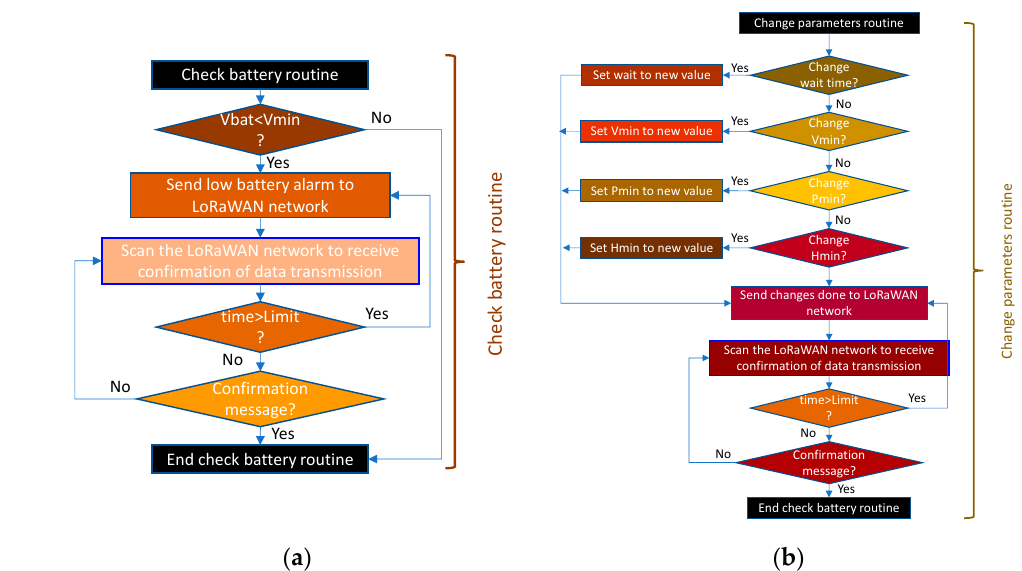
Figure 15. Flow chart of the ( a ) check battery routine and ( b ) change parameters routine for the THMDL.